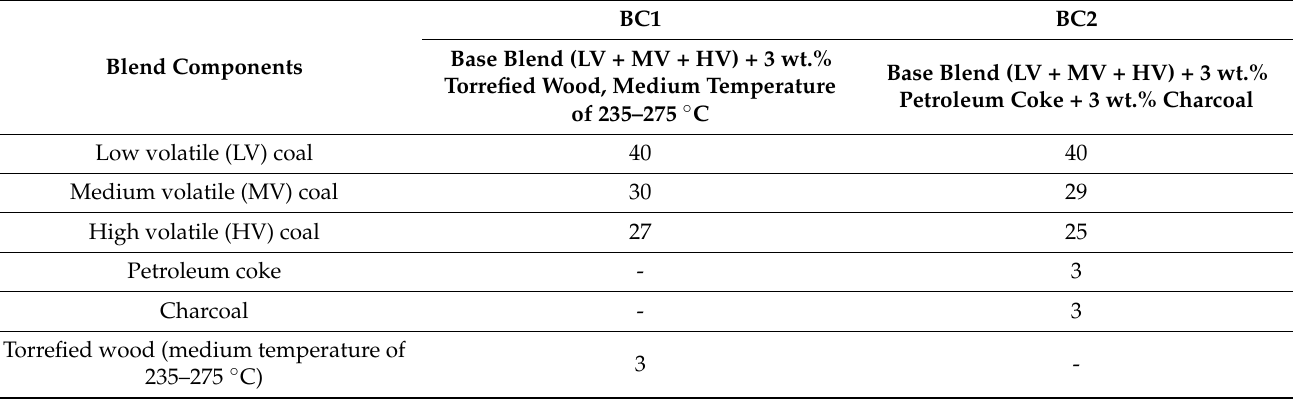
Table 1. Composition of the blend for obtaining BC1 and BC2